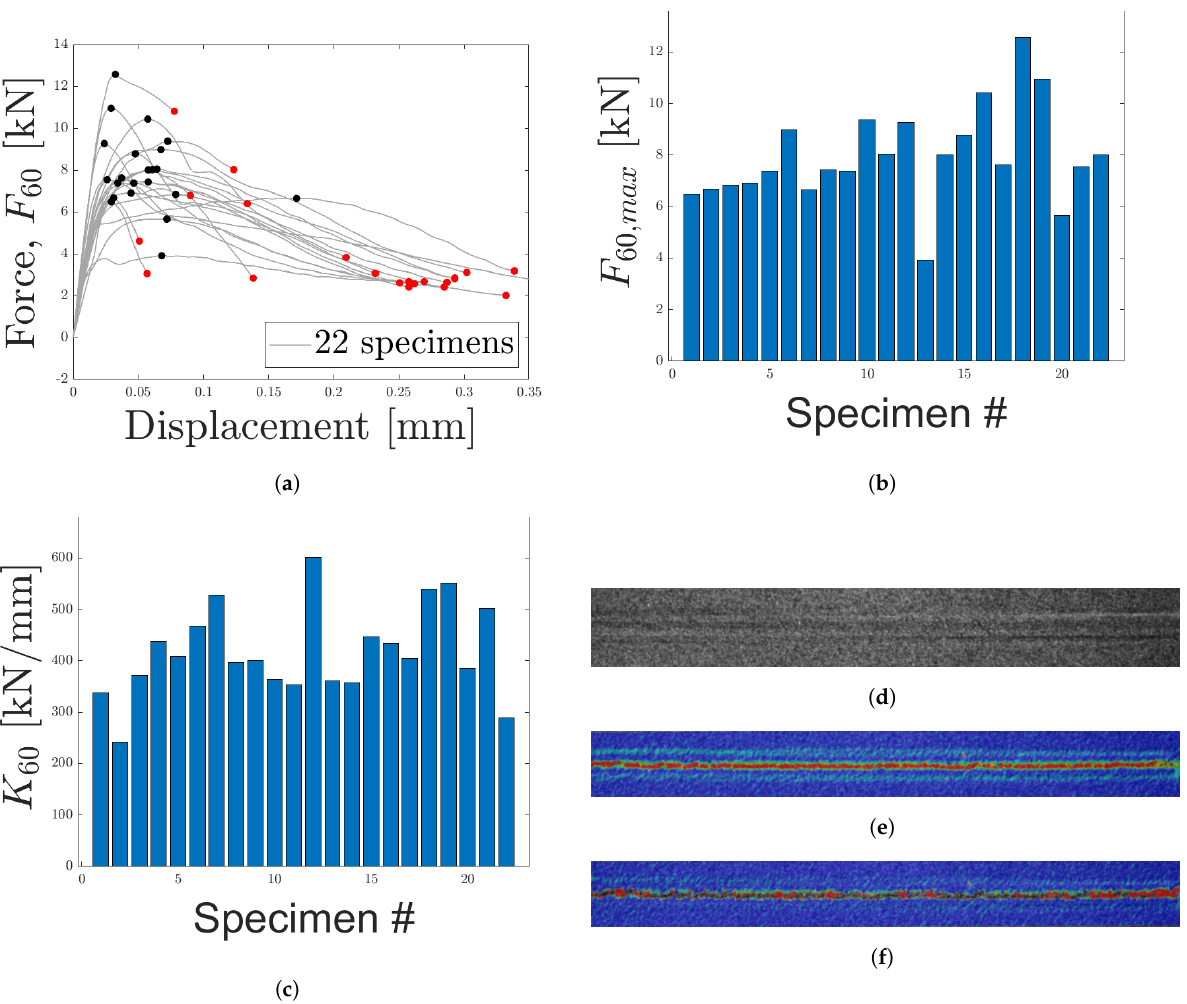
Figure 19. The force–displacement response for LC 5 (60° off axis loading) is presented in ( a ). In ( b , c ) maximum force and stiffness are presented. ( d ) contains the speckle pattern for one of the specimens. In ( e , f ), the strain fields along the loading direction (before and after fracture), obtained using DIC, are